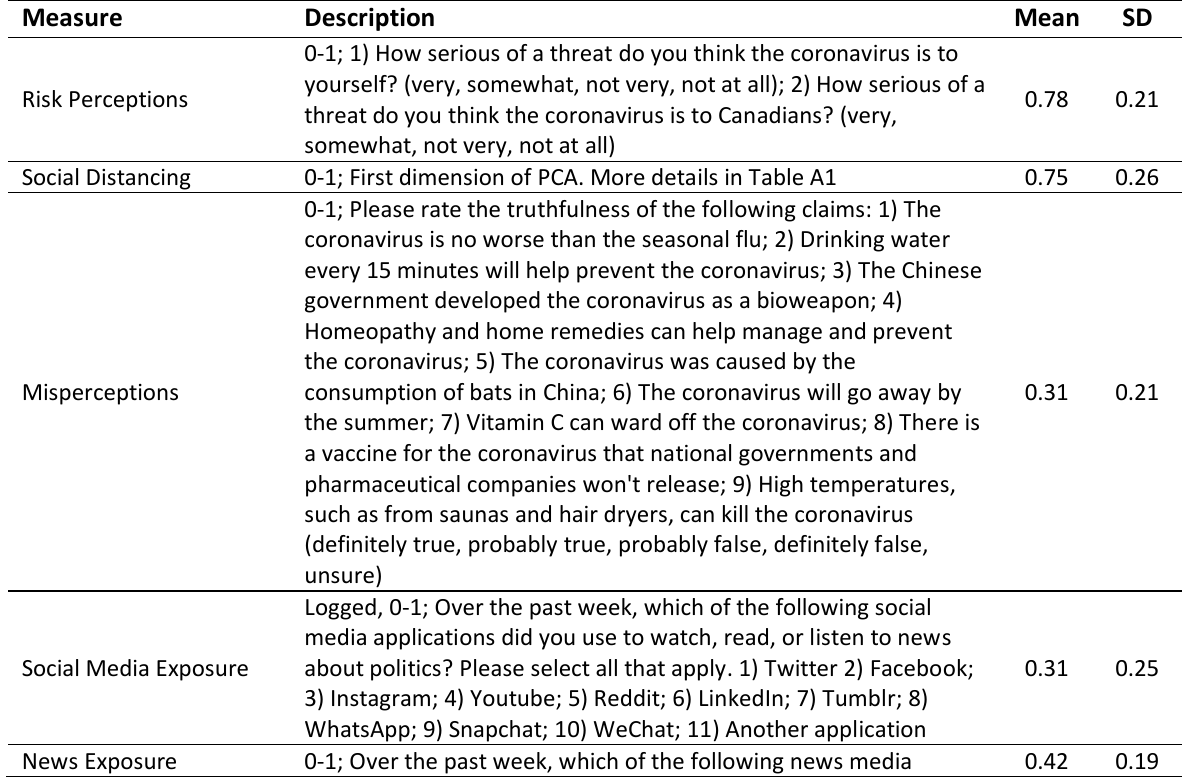
Table A2. Variable